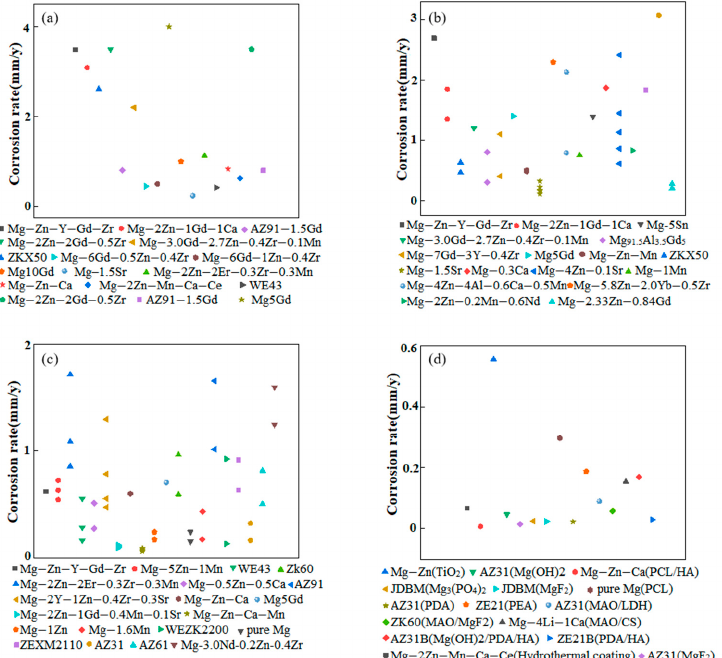
Figure 7. Corrosion performance images of magnesium alloys under different processes. ( a ) As − cast: Mg − Zn − Y − Gd − Zr [60]; Mg − 2Zn − 1Gd − 1Ca [63]; ZKX50 [66]; Mg − 2Zn − 2Gd − 0.5Zr, AZ91 − 1.5Gd, Mg − 3.0Gd − 2.7Zn − 0.4Zr − 0.1Mn, Mg − 6Gd − 0.5Zn − 0.4Zr, Mg − 6Gd − 1Zn − 0.4Zr, Mg5Gd, Mg10Gd [67]; Mg − 1.5Sr [69]; Mg − 2Zn − 2Er − 0.3Zr − 0.3Mn [76]; WE43 [77]; Mg − Zn − Ca [83]; Mg − 2Zn − Mn − Ca − Ce